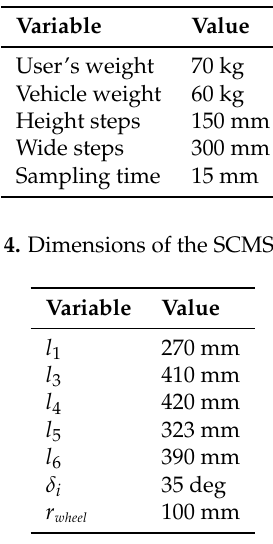
Table 5. Specifications of the motors and